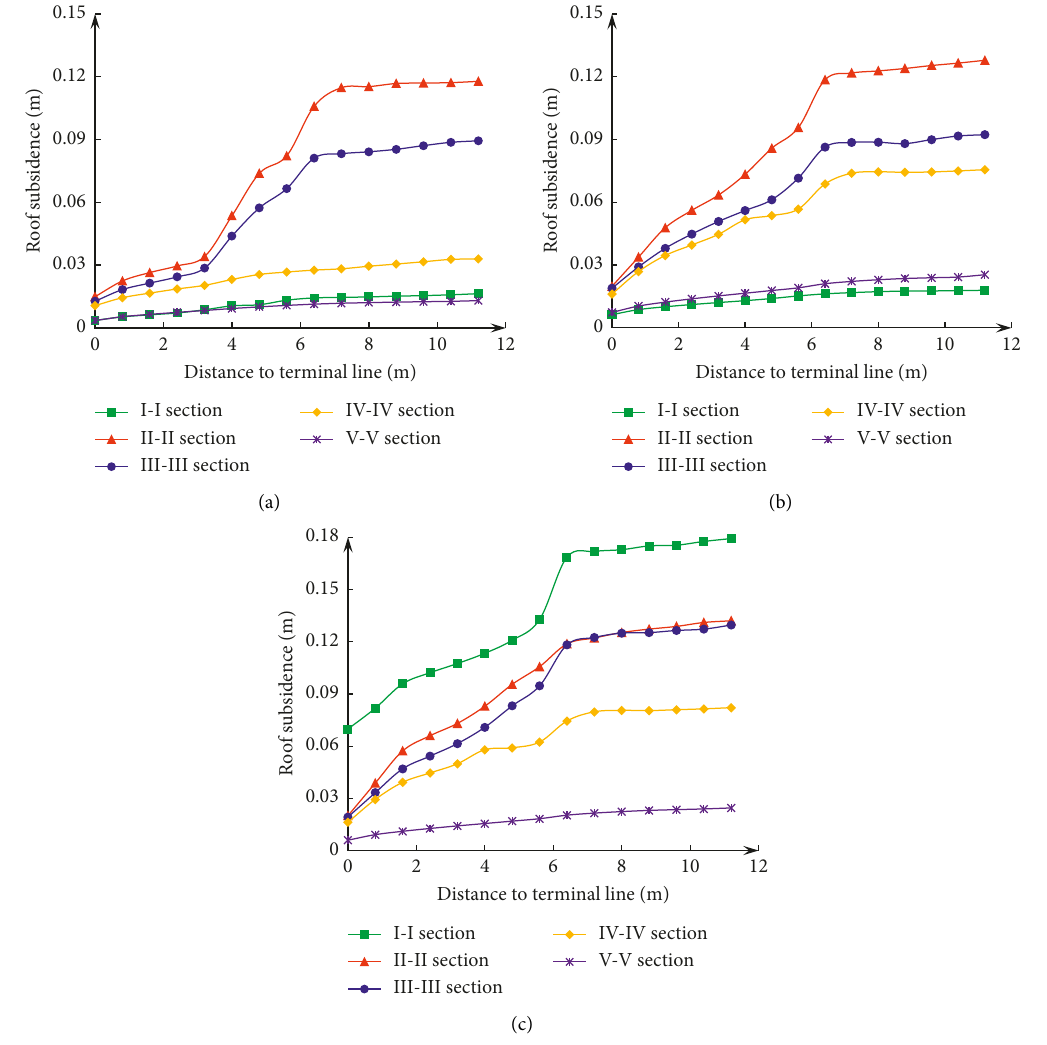
Figure 19: Roof subsidence curves of Stage I. (a) Scheme 1. (b) Scheme 2. (c) Scheme